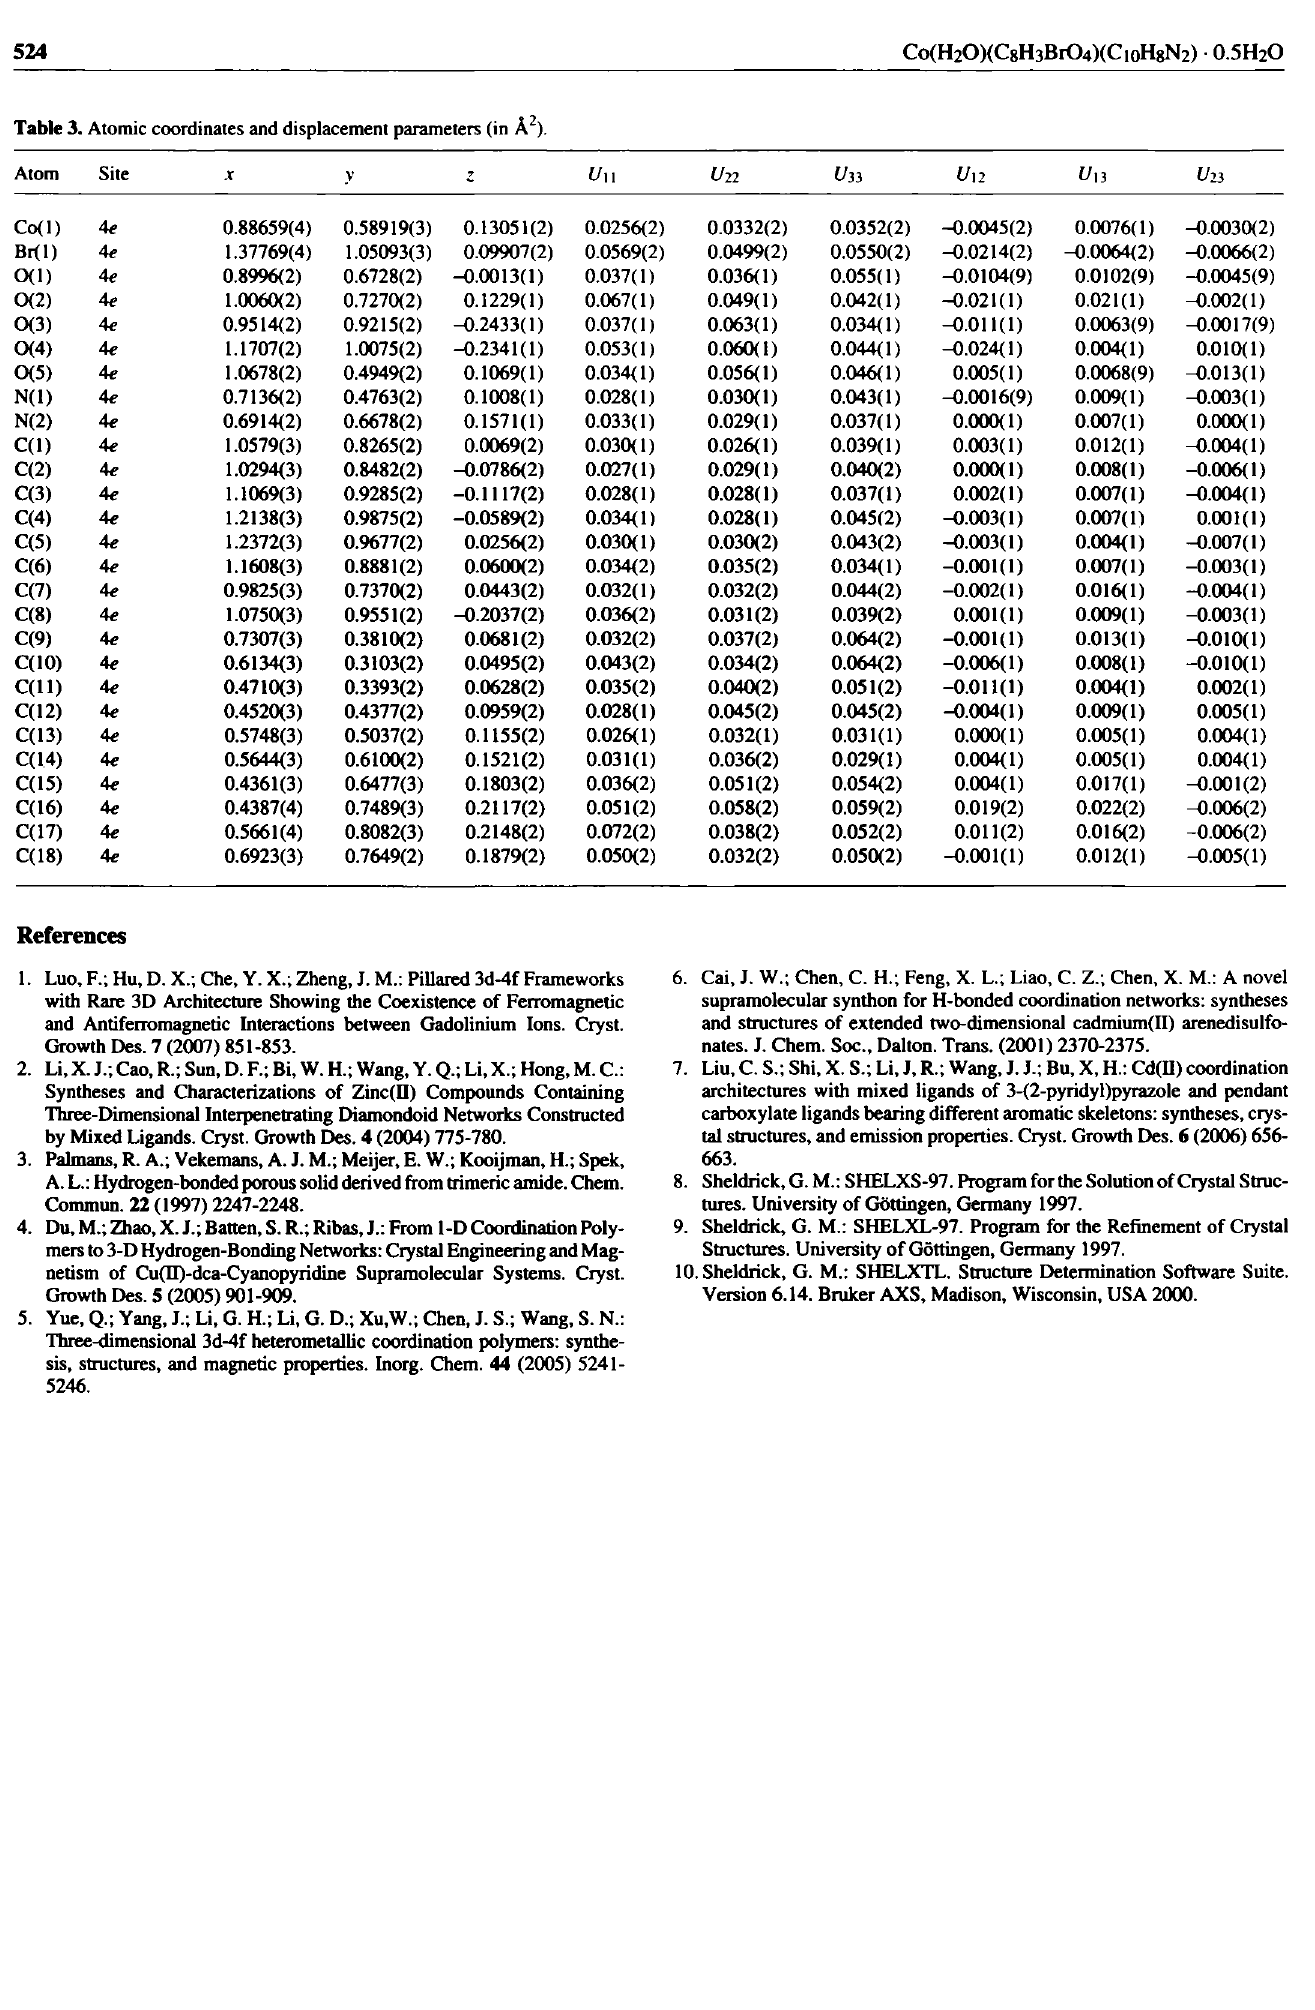
Table 3. Atomic coordinates and displacement parameters (in Â 2